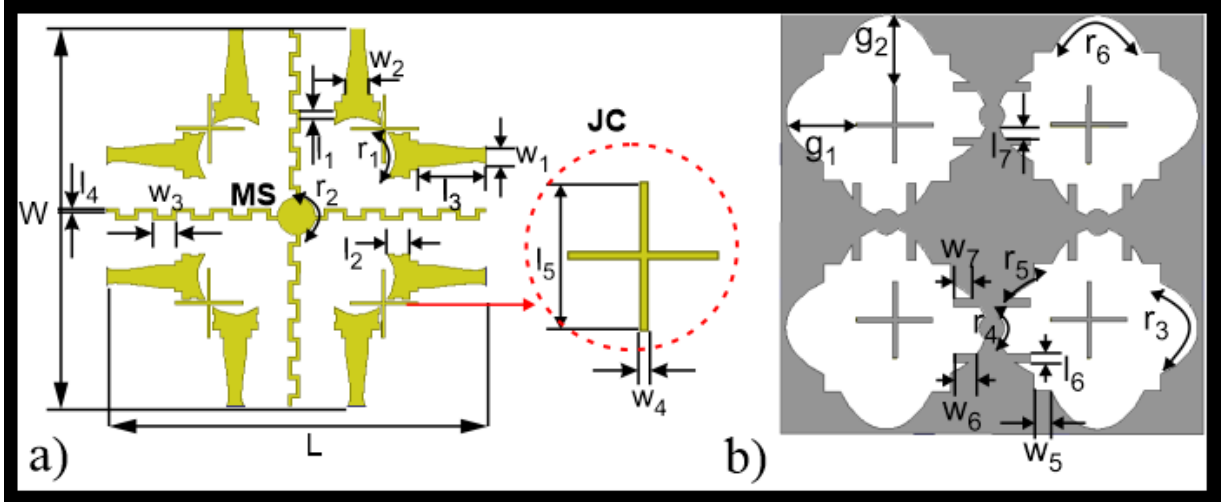
Figure 2. Design of proposed MIMO: ( a ) front view; ( b ) back view.